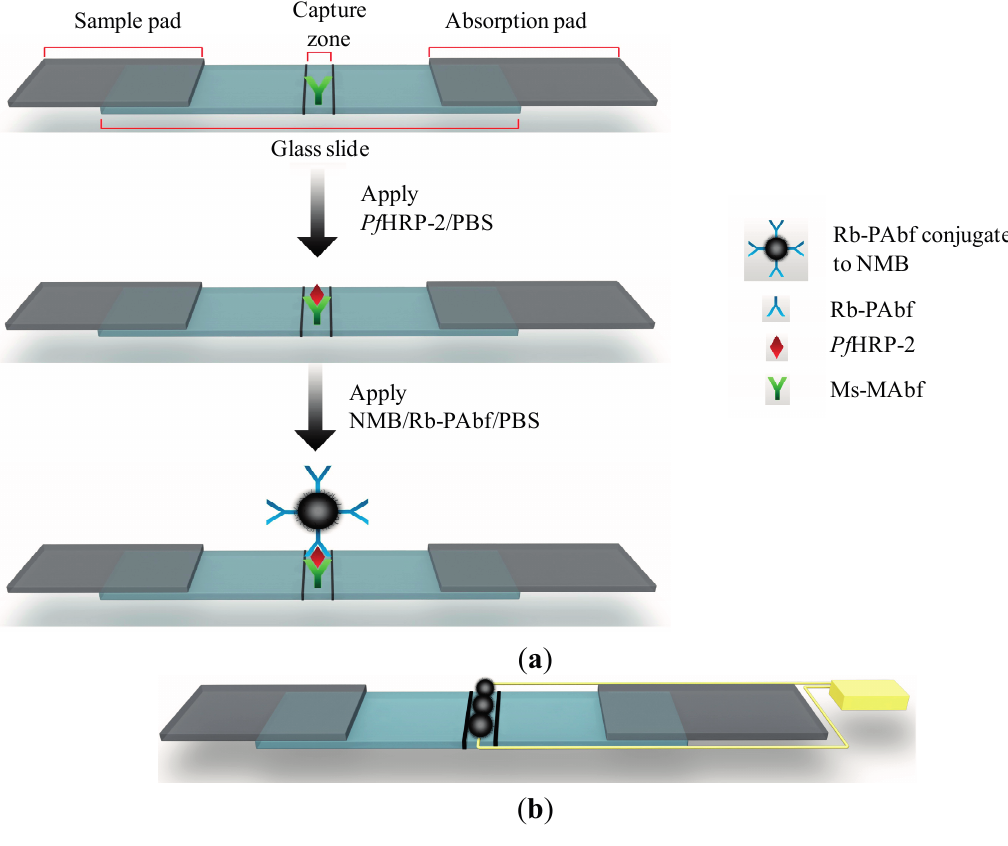
Figure 2. SEM micrographs of air oxidized NMBs at different